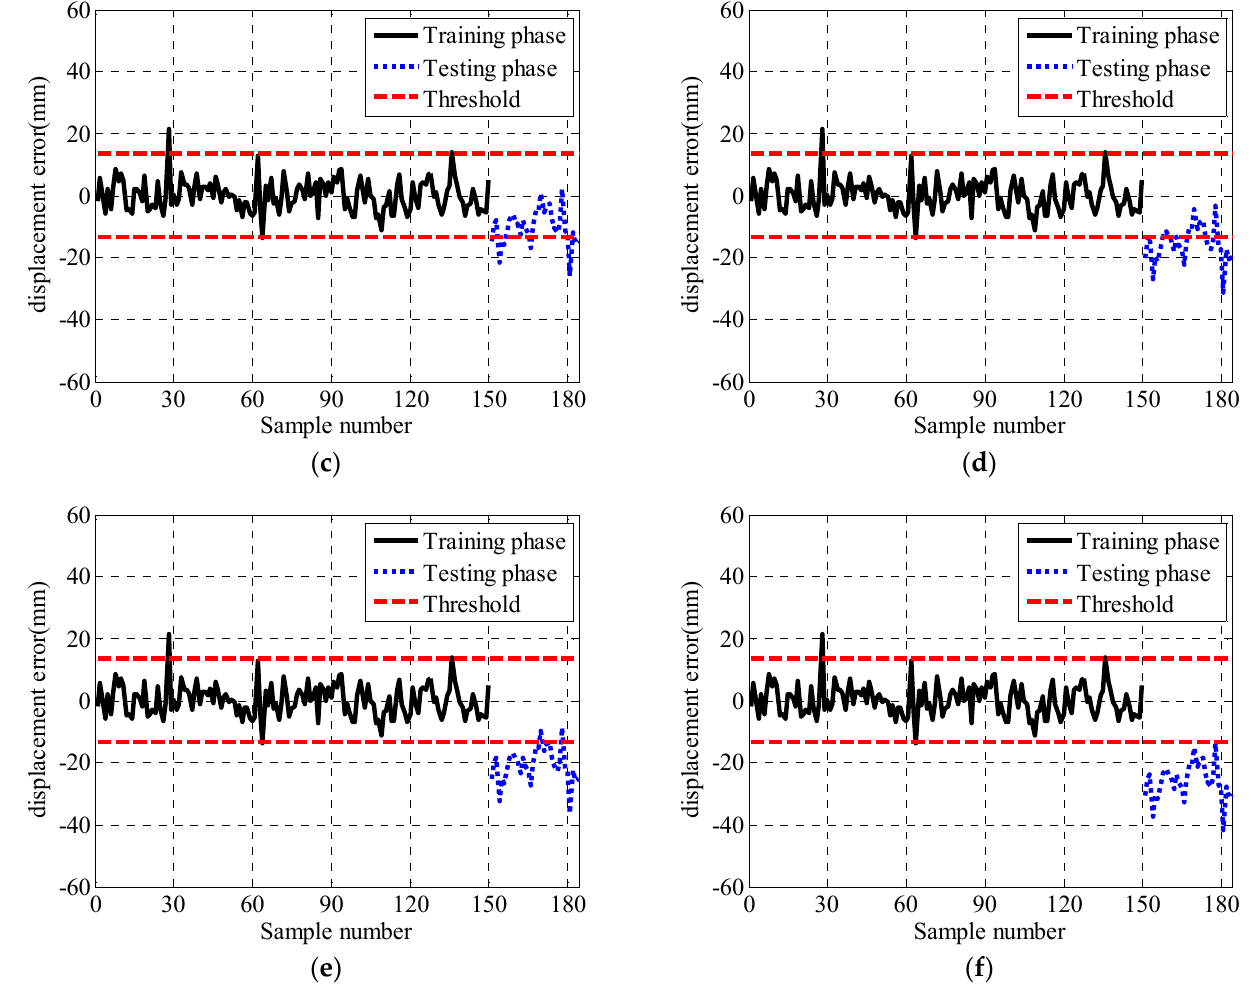
Figure 11. Warning results of the Shewhart control chart. ( a ) Case 1. ( b ) Case 2. ( c ) Case 3. ( d ) Case 4. ( e ) Case 5. ( f ) Case 6.